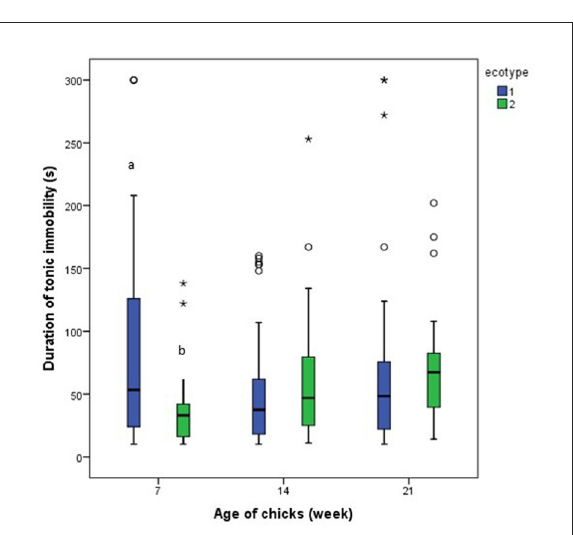
FIGURE10 Duration of tonic immobility in two ecotypes (1 = Yoruba and 2 = Fulani) of Nigerian indigenous chicks at days 7, 14, and 21 post-hatch. ab Means differ at P < 0.05 at day 7 post-hatch. Outliers in the data are depicted by the symbol “* or ◦